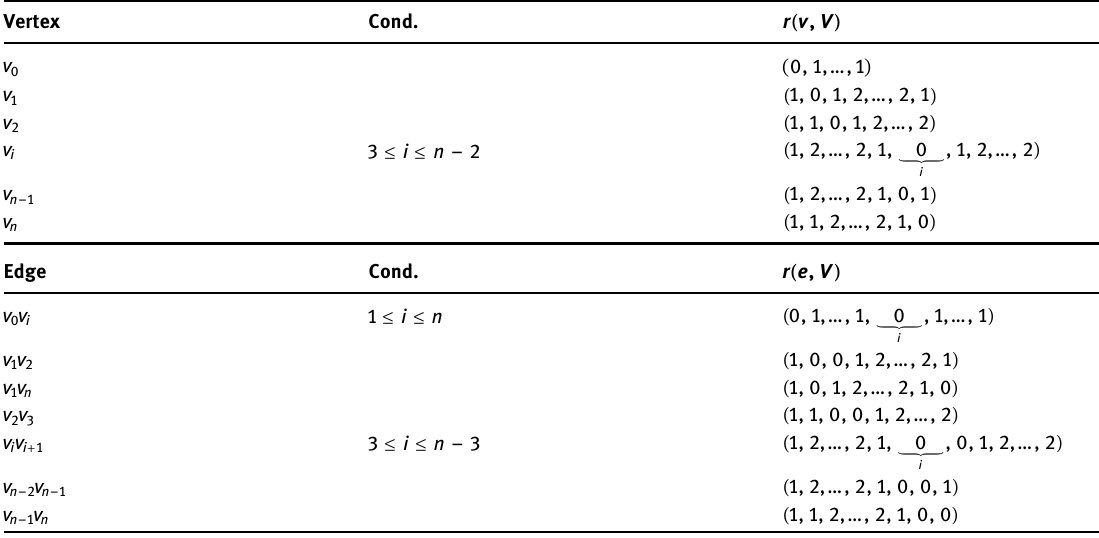
Table 3: Mixed metric representations for W n with respect to V Vertex Cond. v